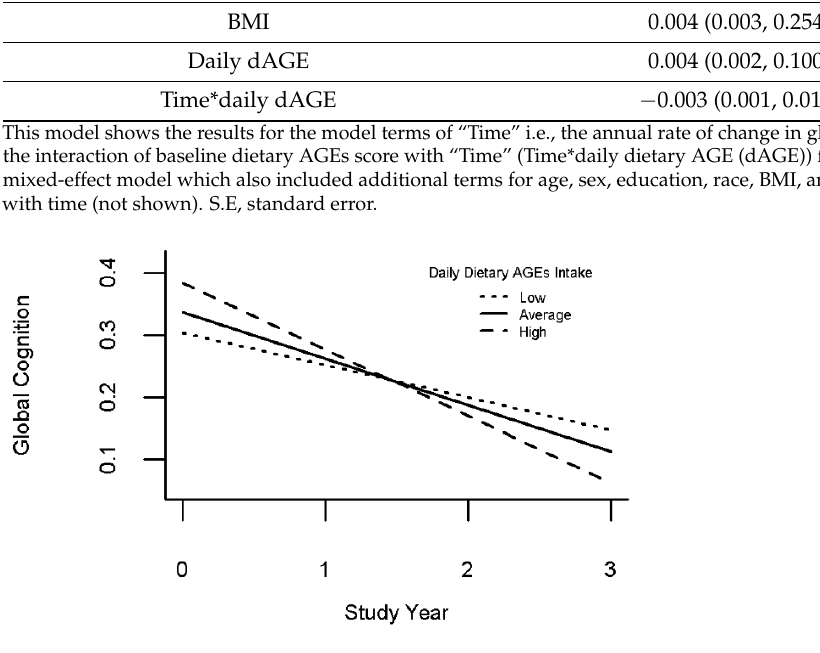
Figure 1. Higher dietary intake of advanced glycation end-products (AGEs) is associated with faster cognitive decline. Rate of cognitive decline in participants with high (90th percentile), average (50th percentile), and low (10th percentile) baseline AGEs. Table 3. Dietary AGEs intake and declining cognitive